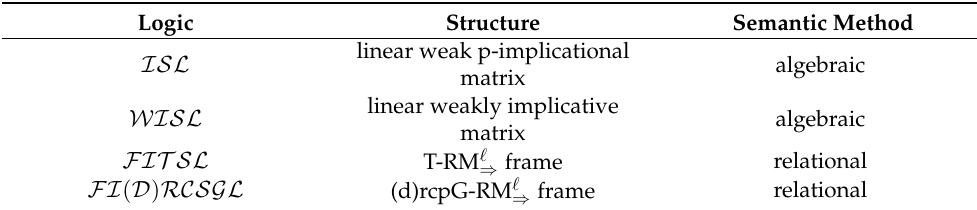
Table 3. Logics and